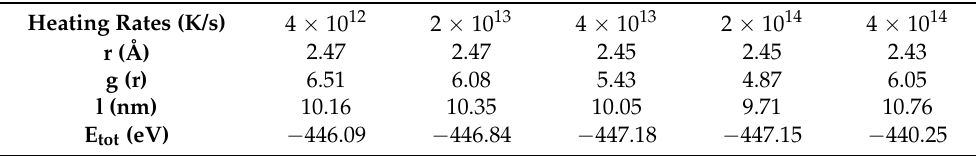
Table 2. The structural features such as r, g(r) of the radial distribution function, l, and E tot with t different heating rates.